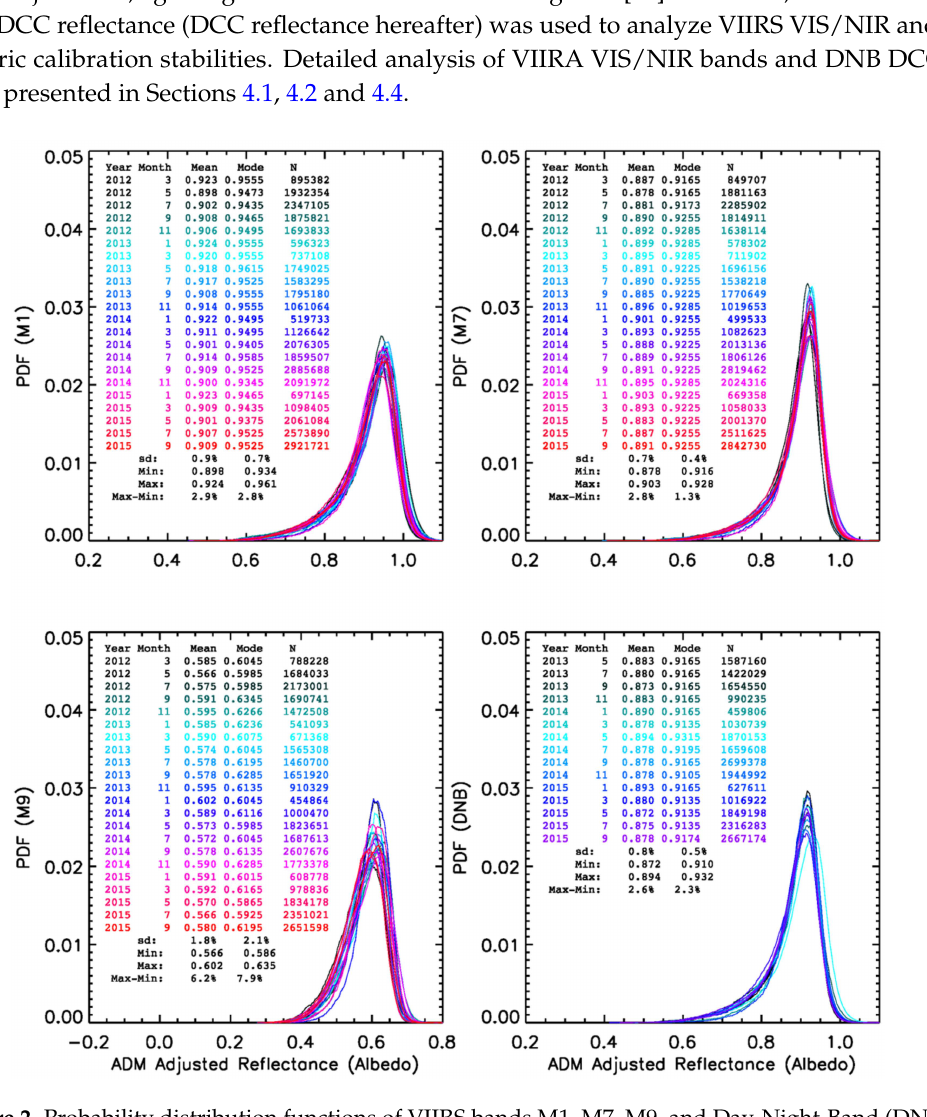
Figure 2. Probability distribution functions of VIIRS bands M1, M7, M9, and Day-Night-Band (DNB) Angular Distribution Models (ADM)-adjusted monthly DCC reflectance. Standard deviation (sd), minimum (Min), maximum (Max), and range (Max ´ Min) were calculated using DCC data from selected